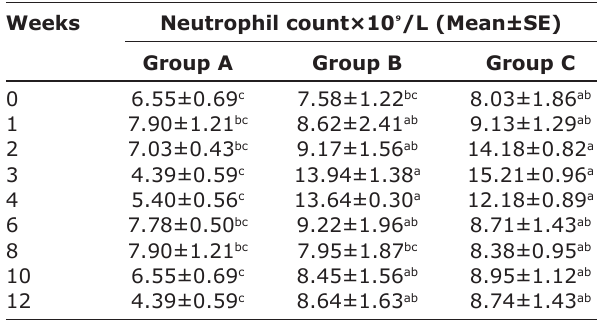
Table-7: Neutrophil count response in female goat’s postinoculation with C. pseudotuberculosis and MA.